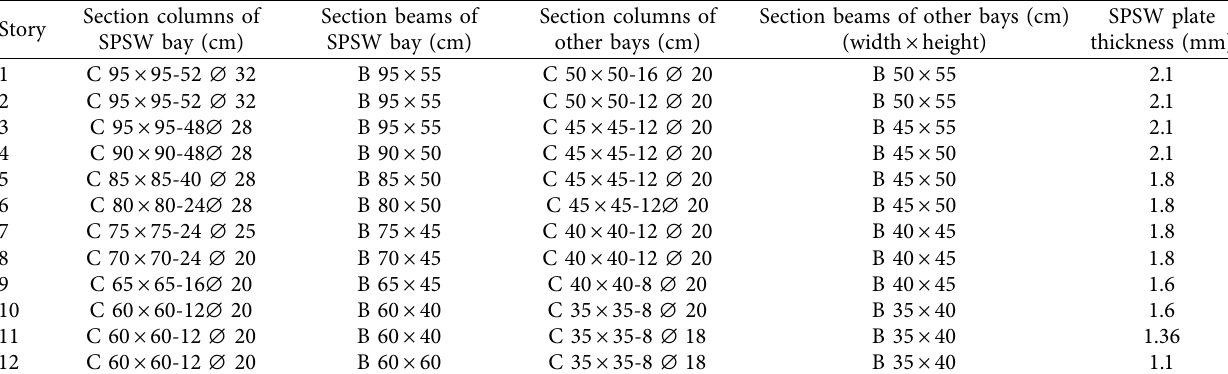
Table 4: Properties of designed beams, columns, and steel plate shear walls of 12-story